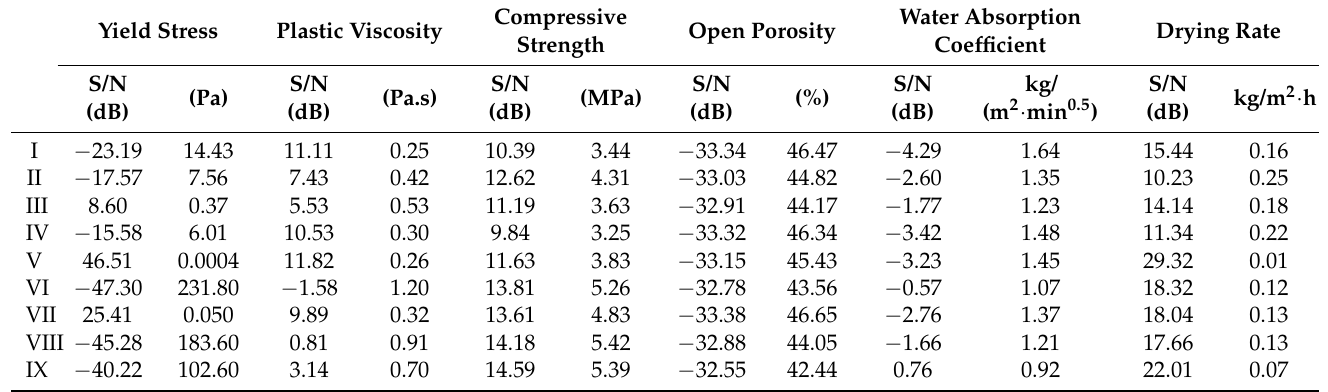
Table 7. S/N ratio and the average values of parameters for each experiment.